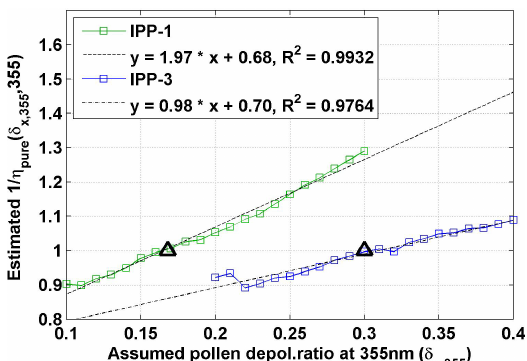
(δ x, 355 ) against the related assumed Figure 13. Estimated 1 η pure pollen depolarization ratio at 355nm ( δ x, 355 ) for IPP-1 (in green) and IPP-3 (in blue). Linear regression lines are drawn by dotted lines, with fitting equations shown. The correlation coefficient ( R 2 ) values are also given. 1 is a parameter using the backscatter-related η Ångström exponent between 355 and 532nm (Eq. 6), and 1 is η pure value for χ pollen (δ x, 355 , 355 ) = 1. The final results the estimated 1 η for pure pollen are shown by the black triangles. Results are un- der the assumption that the backscatter-related Ångström exponent between 355 and 532nm for pure pollen is 0.